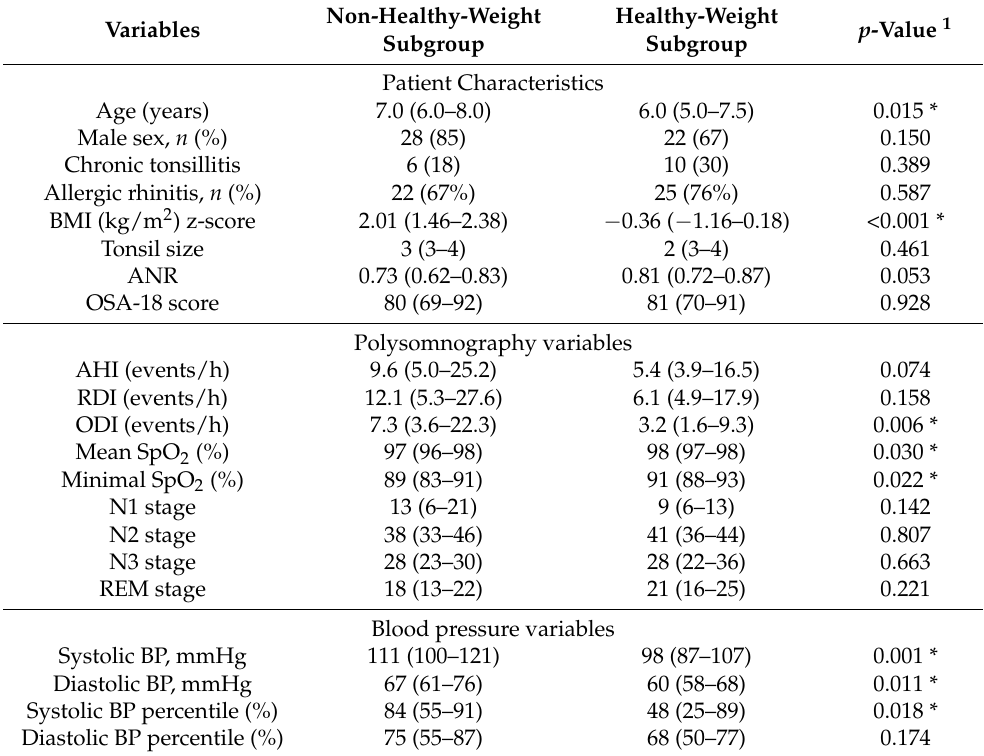
Table 1. Patient characteristics, polysomnography variables, and blood pressures of the different weight status